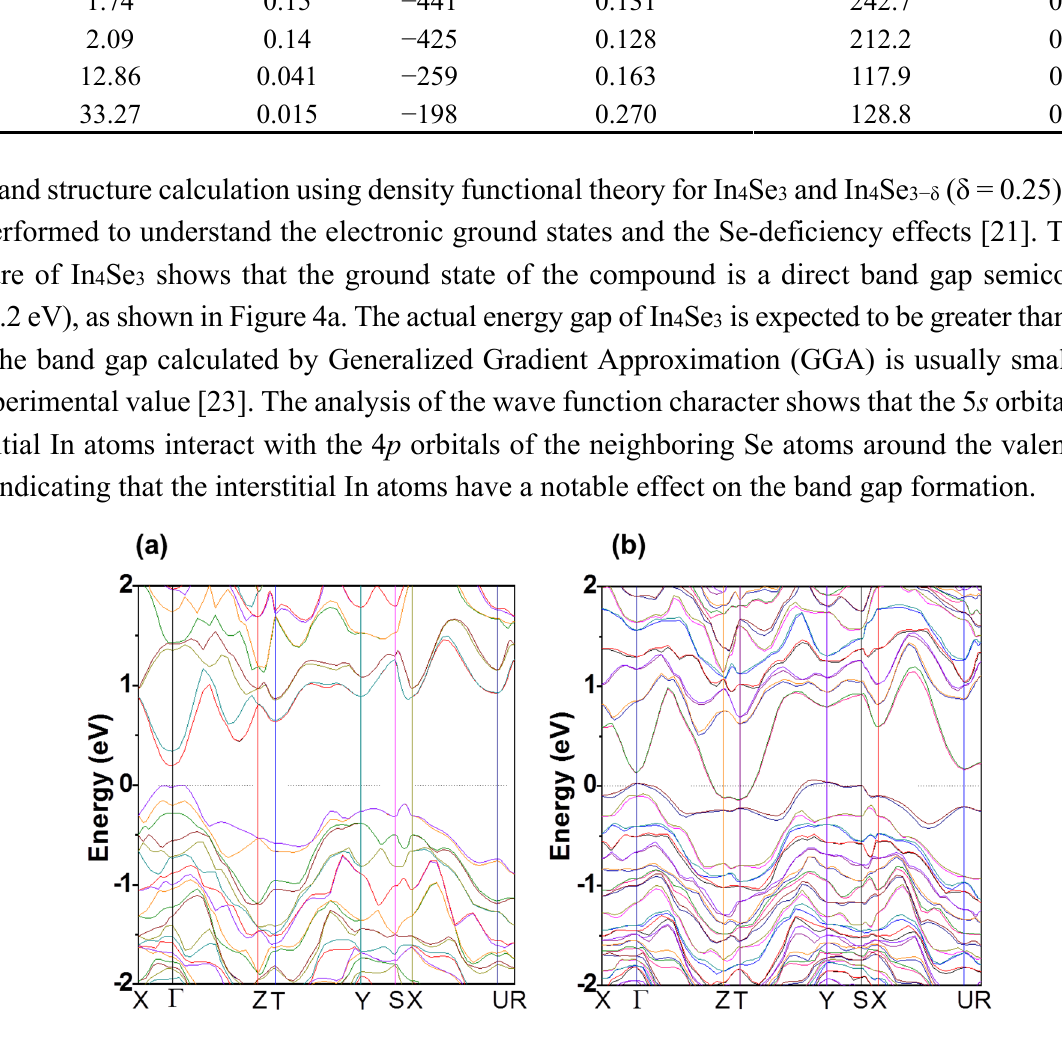
Table 1. The effective carrier concentration (cid:1866) power factor (cid:1845) (cid:2870) σ , Hall mobility of the electron |μ polycrystalline In 4 Se 3 −δ compounds. Reproduced with permission from AIP Publishing LLC, 2009 [21].